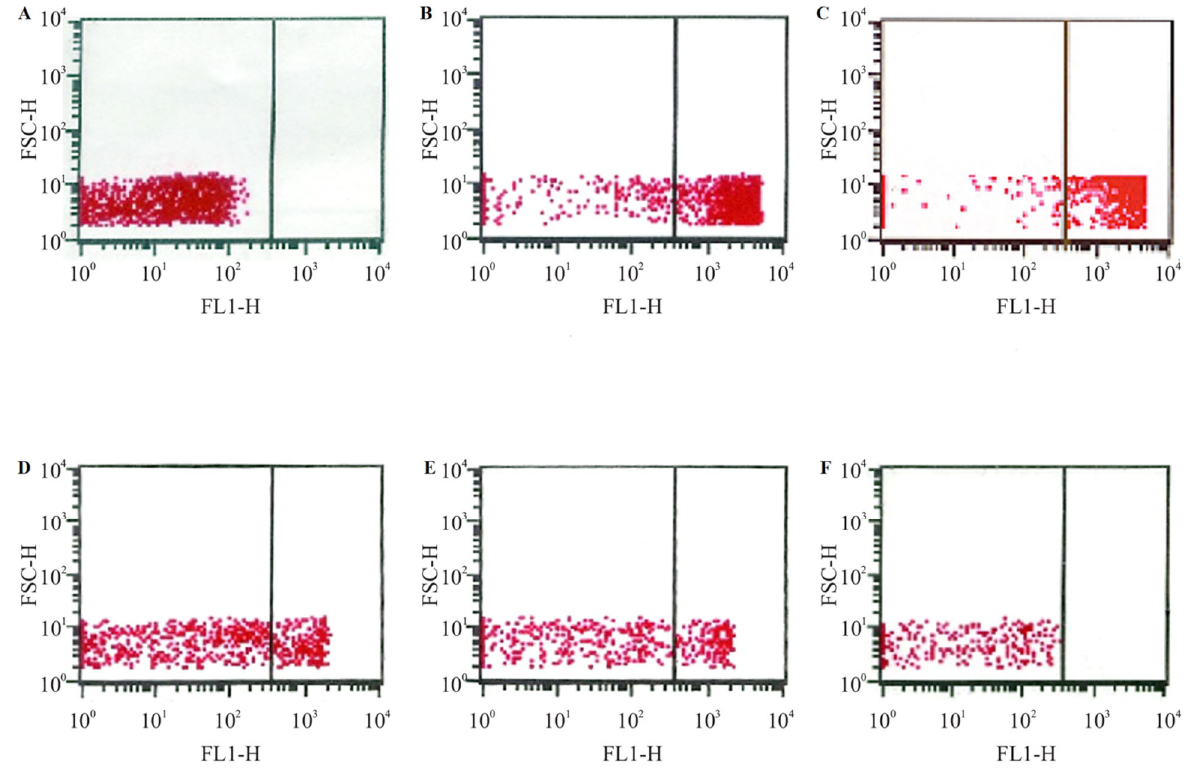
Figure 2. Activity of penicillin-binding protein (PBP) in clones recovered at 64 × MIC measured by flow cytometry. ( A ) Control 1390S without fluorescent ampicillin, ( B ) control 1390S with fluorescent ampicillin, ( C ) control strain 29212, control of ampicillin-sensitive E. faecalis , ( D ) strain 1390S stimulated with 0.25 × MIC, ( E ) strain 1390S stimulated with 0.5 × MIC, and ( F ) strain 1390R stimulated with 64× MIC. The resulting bacterial clone (1390R) had a total loss of ability to bind PBP or penicillin.